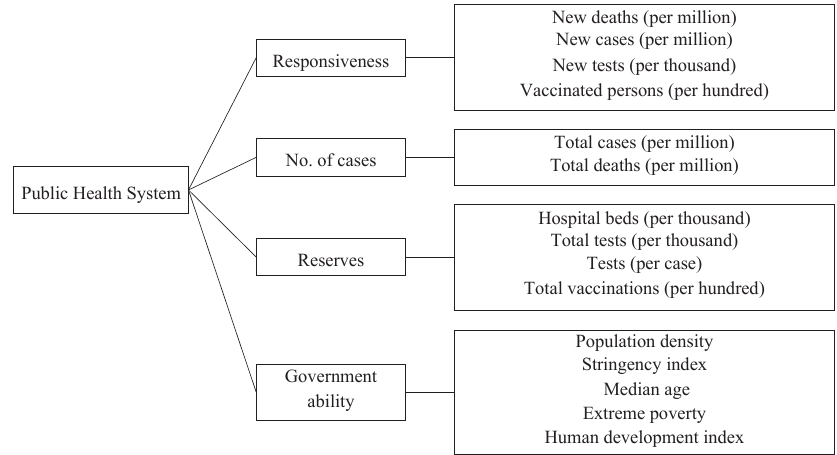
Figure 3. The hierarchy structure of indicators and factors in this evaluation